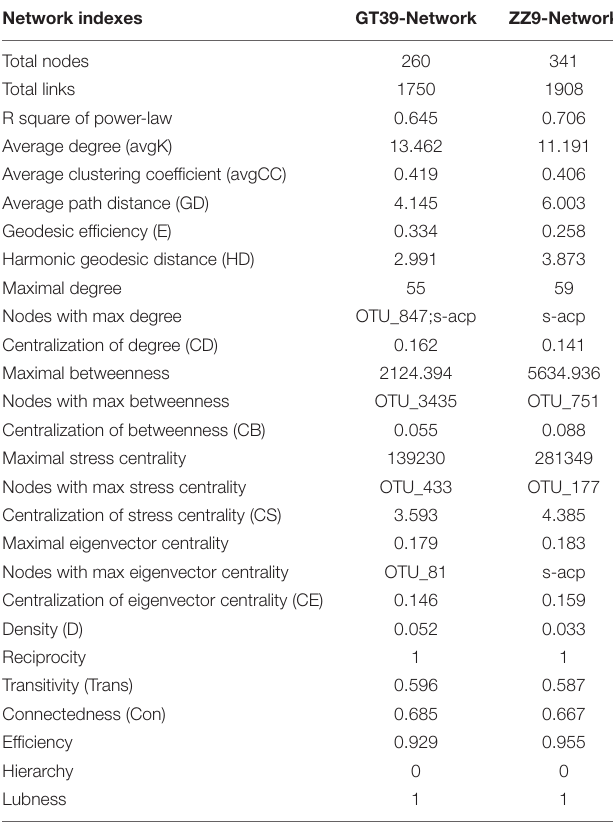
TABLE 3 | Topological characteristics of two varieties Network